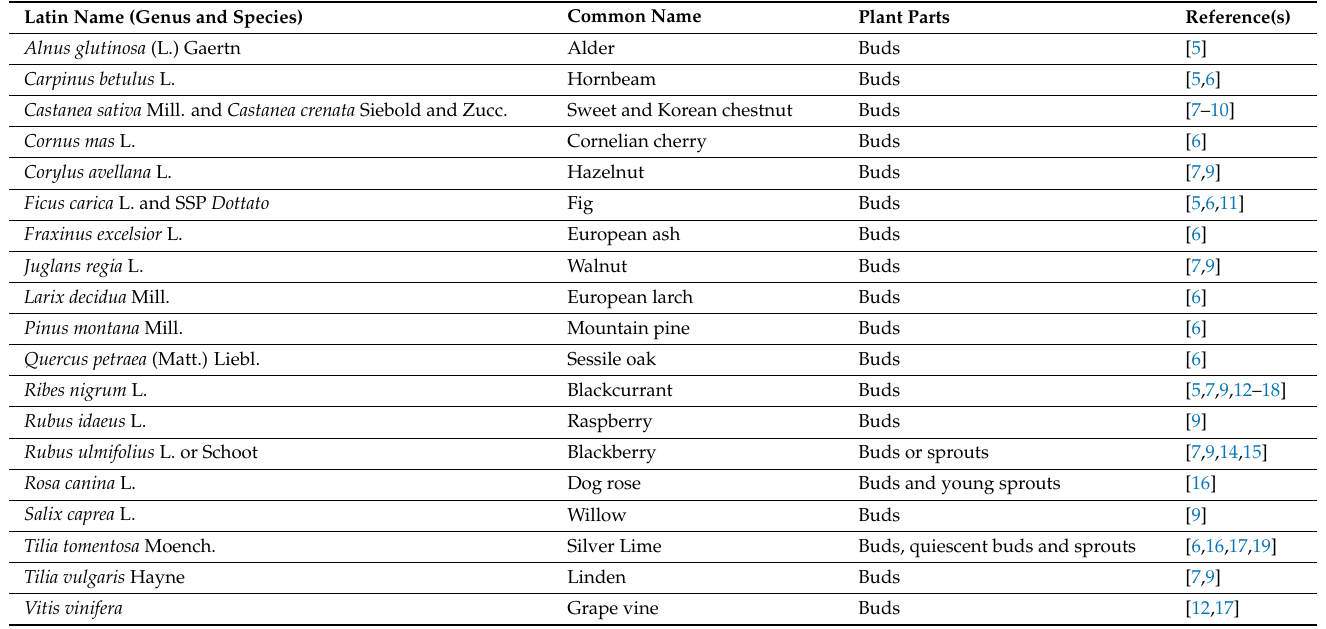
Table 1. Bud macerates related in the